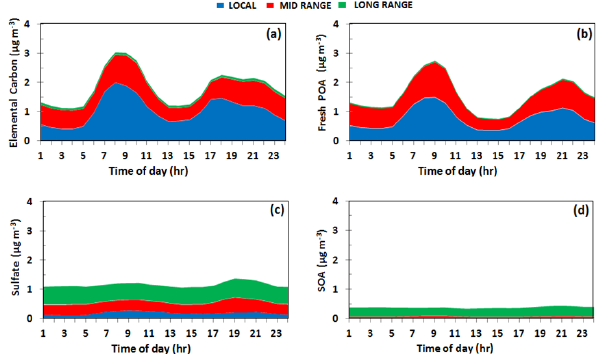
Fig. 8. Average diurnal profiles of PM 2 . 5 components and corre- sponding source areas for the winter period simulated for: (a) ele- mental carbon, (b) fresh POA, (c) sulfate, and (d) SOA.